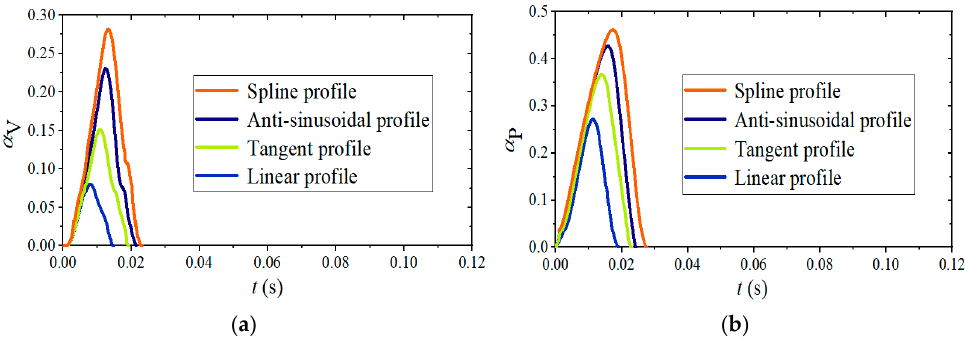
Figure 10. Average vapor distribution of different CGPs. ( a ) Valve port average VVF; ( b ) pump chamber average VVF.